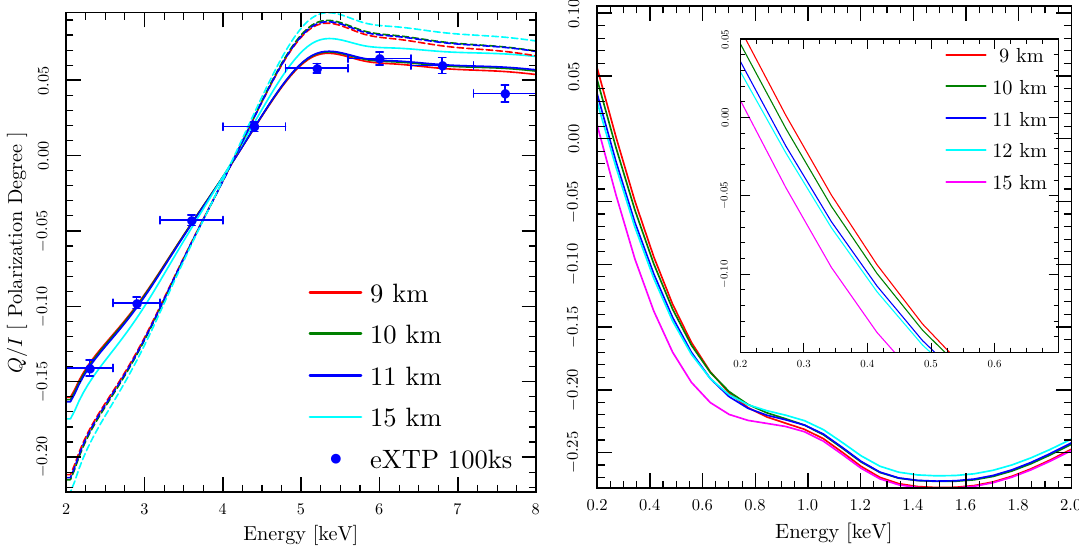
Figure 4. The polarization from Her X-1 as function of photon energy using the emission models of [12,42], averaged over the rotation of the pulsar. A positive value of the polarization degree indicates that the polarization direction is perpendicular to the projection of the rotation axis onto the plane of the sky. In the left panel, the dashed lines give the result without vacuum birefringence (we have reversed the polarization direction in this case for ease of comparison, see the text) and the solid lines include the QED effect. A positive value of Q / I indicates that the net polarization is perpendicular to the projected spin axis of the stars in the QED-on case, and parallel in the QED-off case. The crosses give the results of a 100-ks simulated observation with eXTP. The results for IXPE are similar with a 300-ks